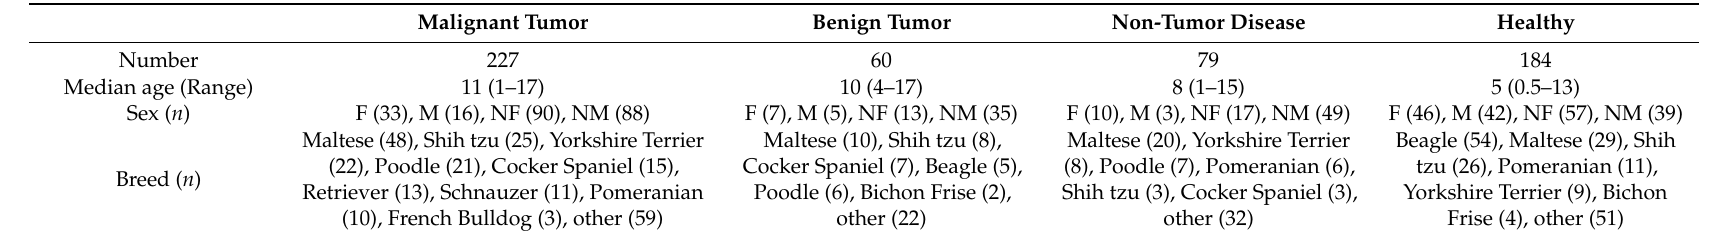
Table 1. Signalment data for dogs enrolled in this study.